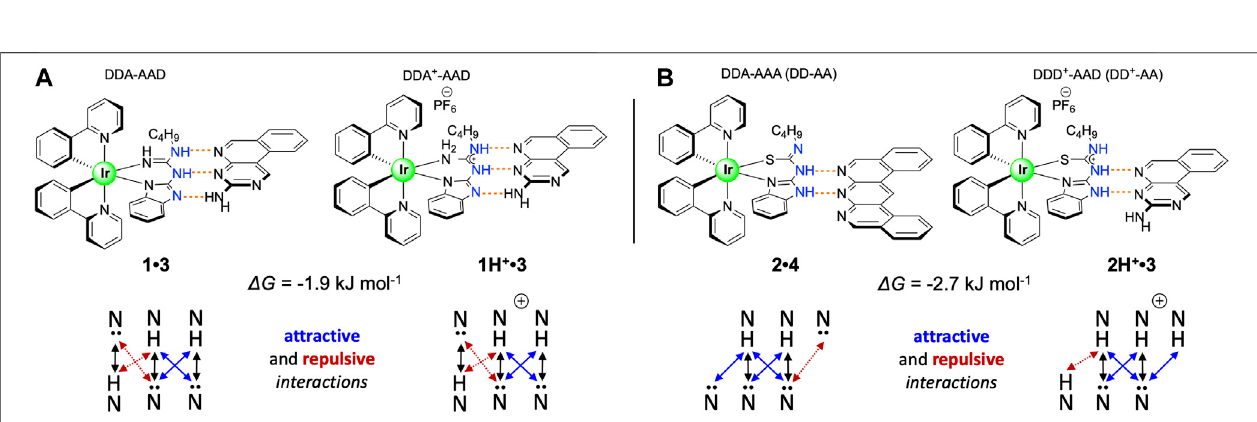
FIGURE 4 | Structural comparison of co-systems (A) 1 association events.